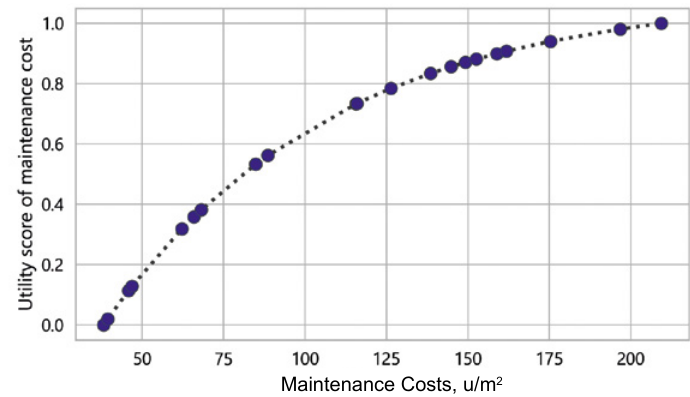
Figure 3. Single Utility Score of Maintenance